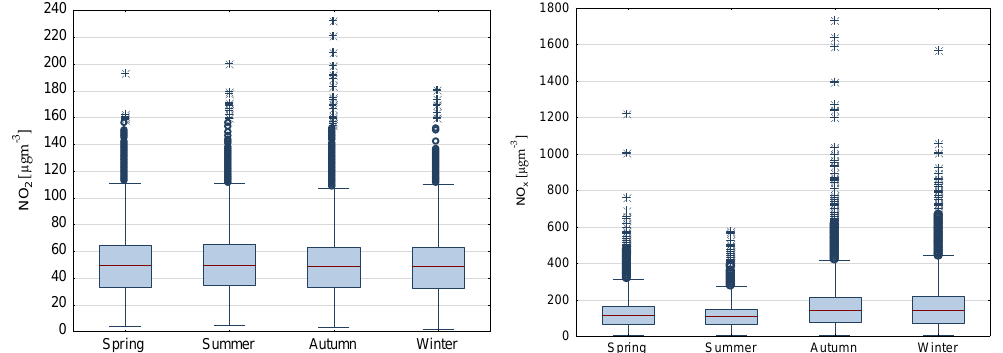
Figure 1. Box plots for hourly nitrogen oxides concentration 2015–2017.